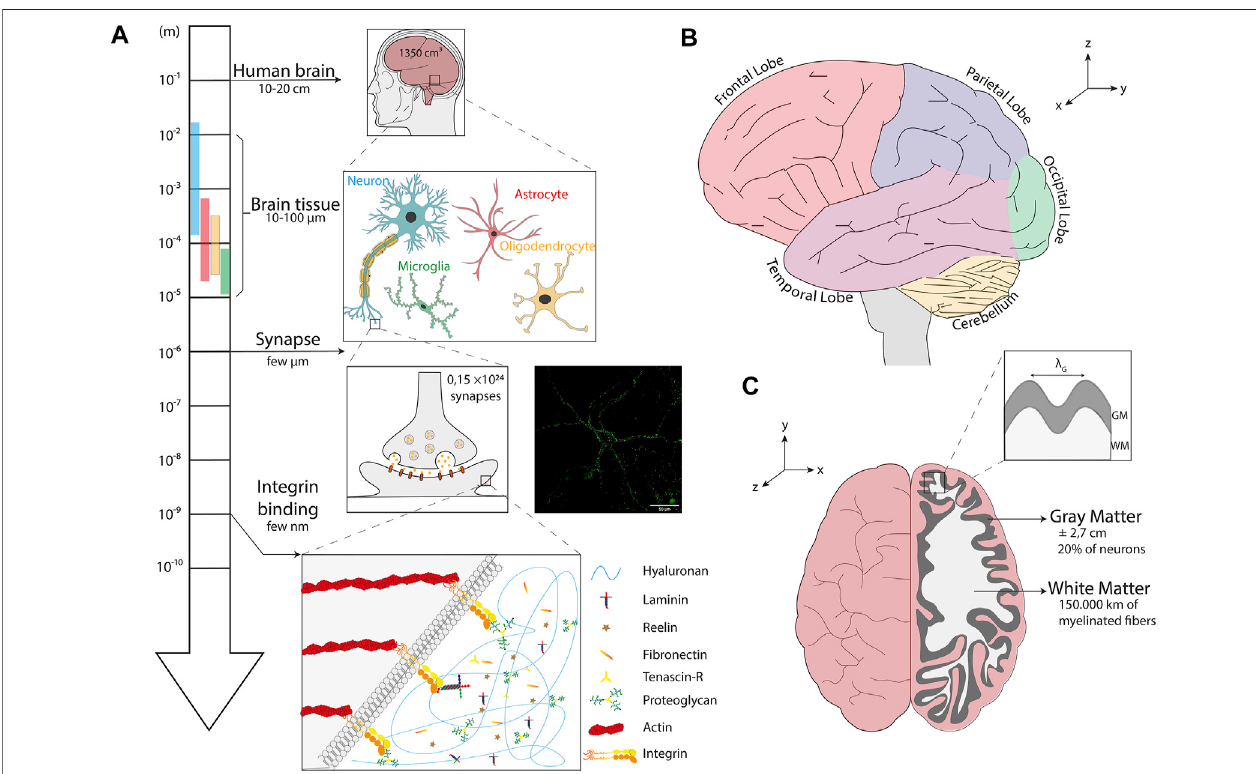
FIGURE 1 | The multi-scale structure of the human brain. (A) Homeostasis of brain tissues mainly relies on the interaction between four cell types: neurons, microglial cells, astrocytes and oligodendrocytes. At the subcellular scale, synapses allow the transmission of an electrical or chemical signal from a neuron to another one or to the target effector cell. The inset shows an image of a neuron isolated from an organotypic slice of hippocampus labeled with synaptotagmin (in green), a presynaptic calcium sensor. The scale bar is 50 µm. At the molecular scale, transmembrane integrins connect proteins of the extracellular matrix to cytoskeletal components. (B) Illustration of a sagittal section of a normal human brain whose different lobes are color-coded: the frontal lobe in red, the parietal lobe in blue, the occipitallobeingreen,thetemporallobeinpurple andthecerebelluminyellow. (C) Illustration ofatopviewofanormalhumanbrainwithacrosssectionoftherightlobe showingtheorganizationofthecerebralcortex(graymatter)andsubcorticalregions(whitematter).Theinsetdepictsthewavelength( λ G )ofcorticalfolds,thegreymatter (GM) and the white matter (WM).